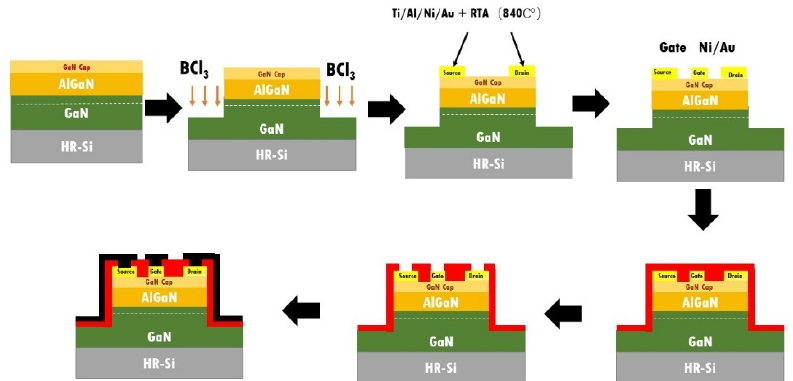
Figure 2. Schematic process flow of T-shaped AlGaN/GaN HEMT.